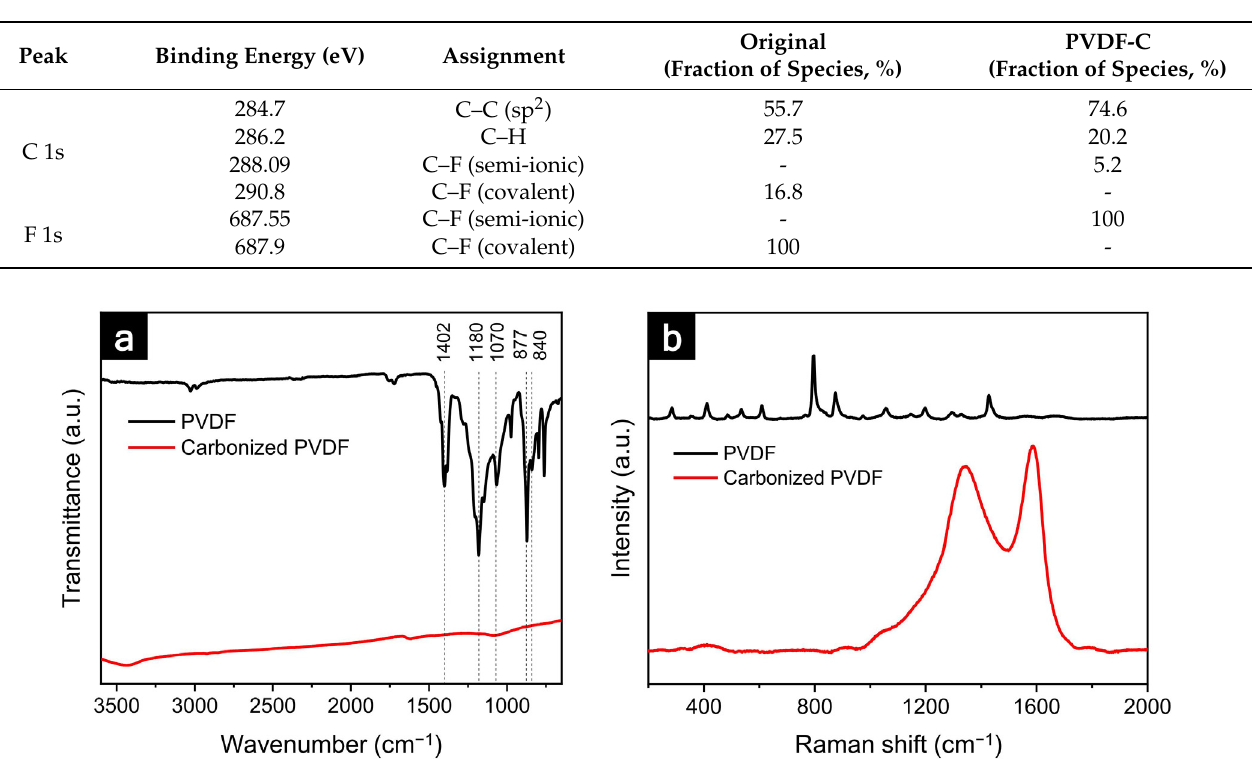
Figure 1. XPS data of ( a ) C and ( b ) F before and after the carbonization of the graphite anode. Table 1. Comparison of the XPS spectra for relative atomic percentages before and after the carboniza- tion of the original graphite anode.